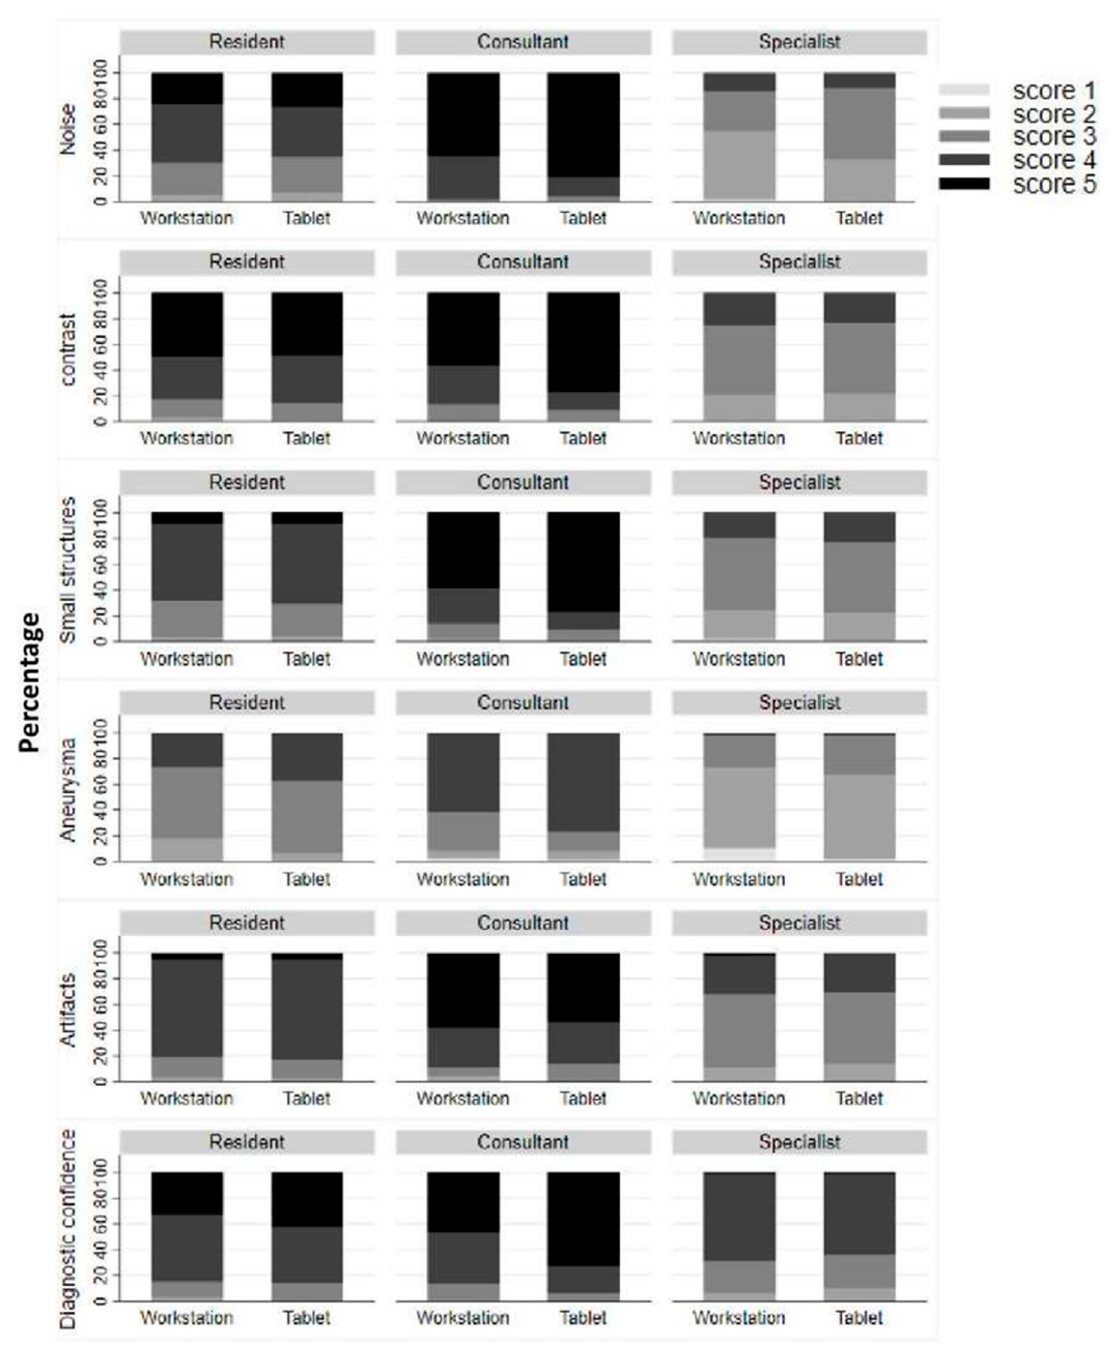
Figure 5. Results for subjective image quality parameters. Please find details in the methods section.